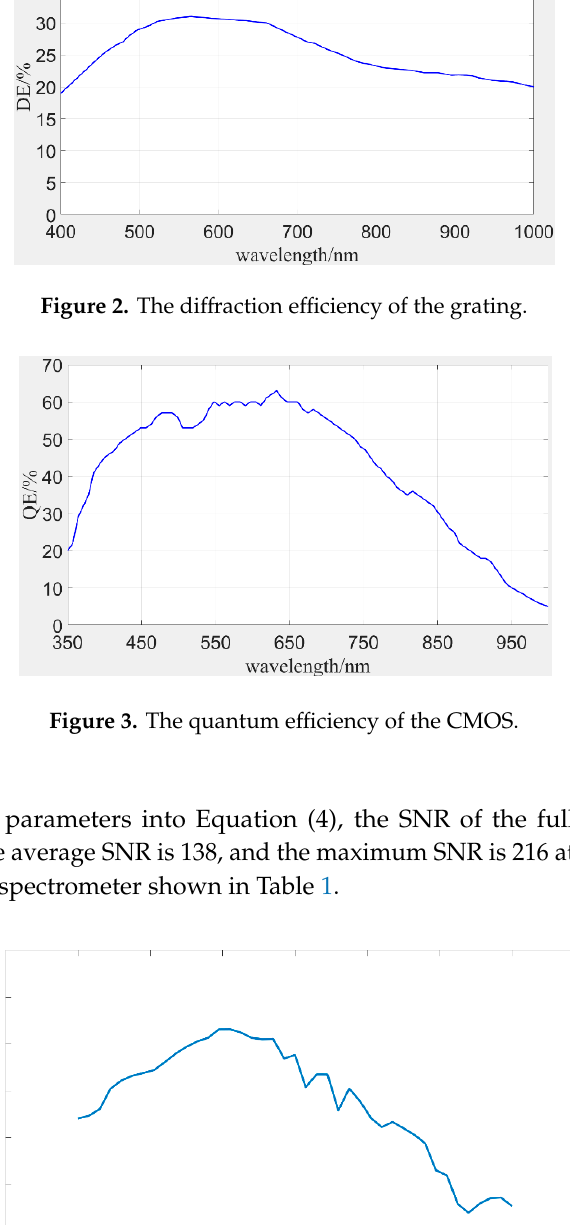
Figure 2. The diffraction efficiency of the grating.